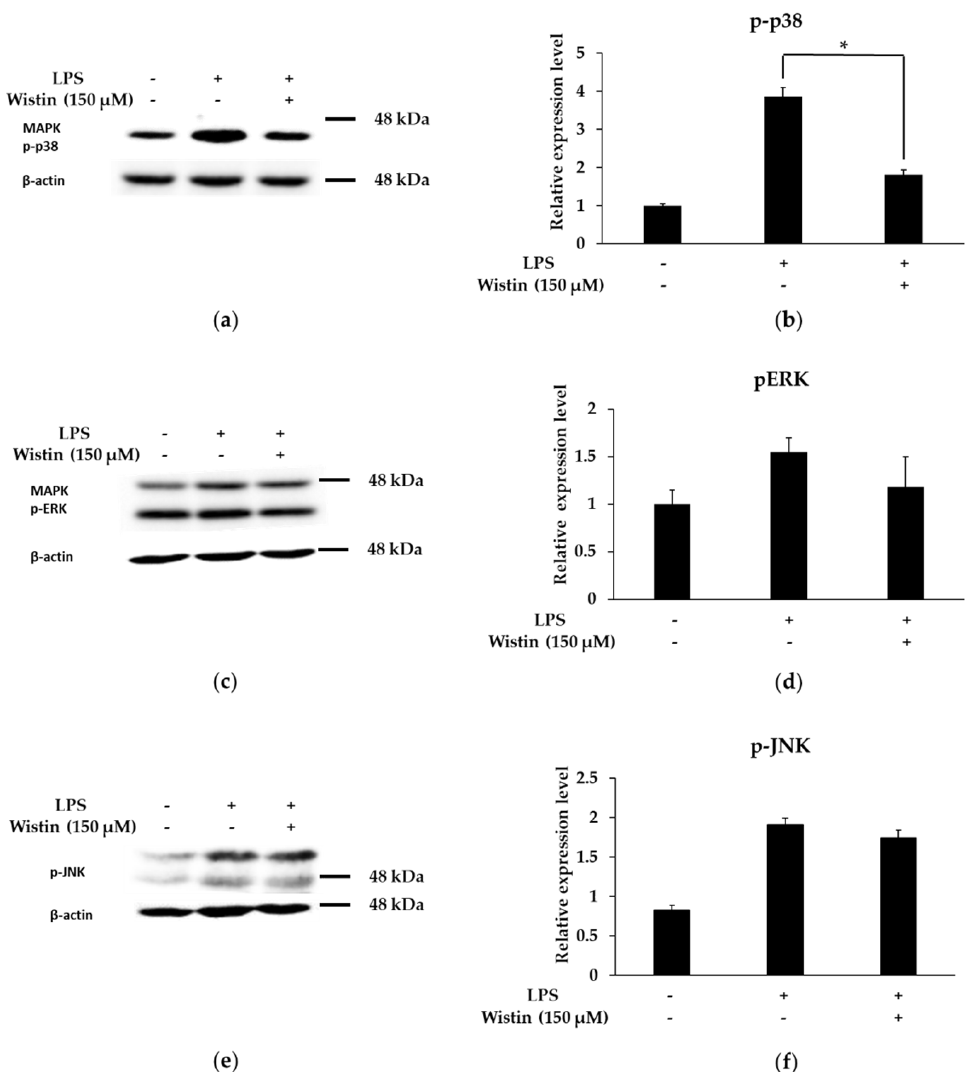
Figure 6. The effects of wistin on MAPK (p-p38, p-ERK, and p-JNK) in LPS-induced RAW 264.7cells. The cells were treated with the indicated concentrations of wistin for 30 min prior to treatment with LPS (0.1 μg/mL) for 2 h. Phosphorylation of p38 ( a ), ERK, ( c ) and JNK ( e ) was measured using a Western blot. Quantitative analysis of the p-p38/β-actin ( b ), p-ERK/β-actin ( d ), and p-JNK/β-actin ( f ) using image J. * p < 0.05 compared with the LPS-treated group. The data are presented as the means ± SD; n = 2.